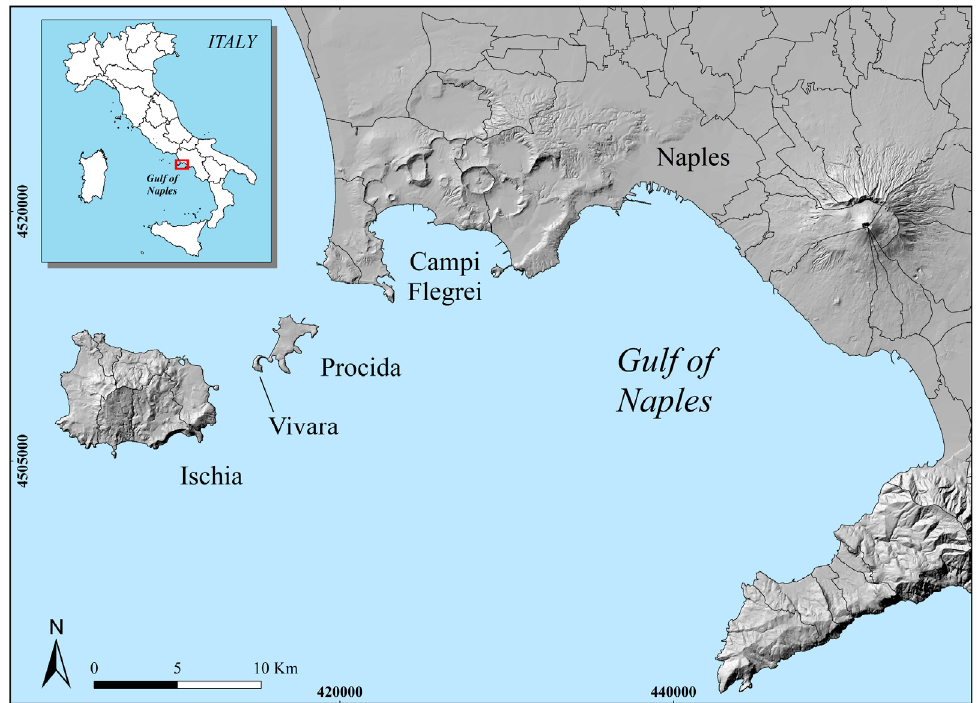
Figure 1. Location of Ischia Island within the Gulf of Naples, Southern Italy. Geographic coordinate system is UTM 33N, WGS 84.